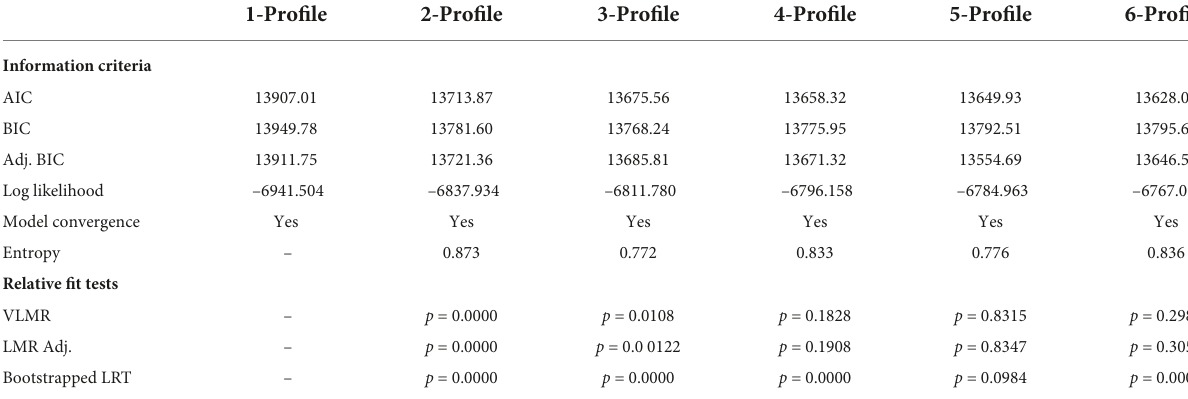
TABLE 3 Fit for latent profile models of age 2 fear behavior.